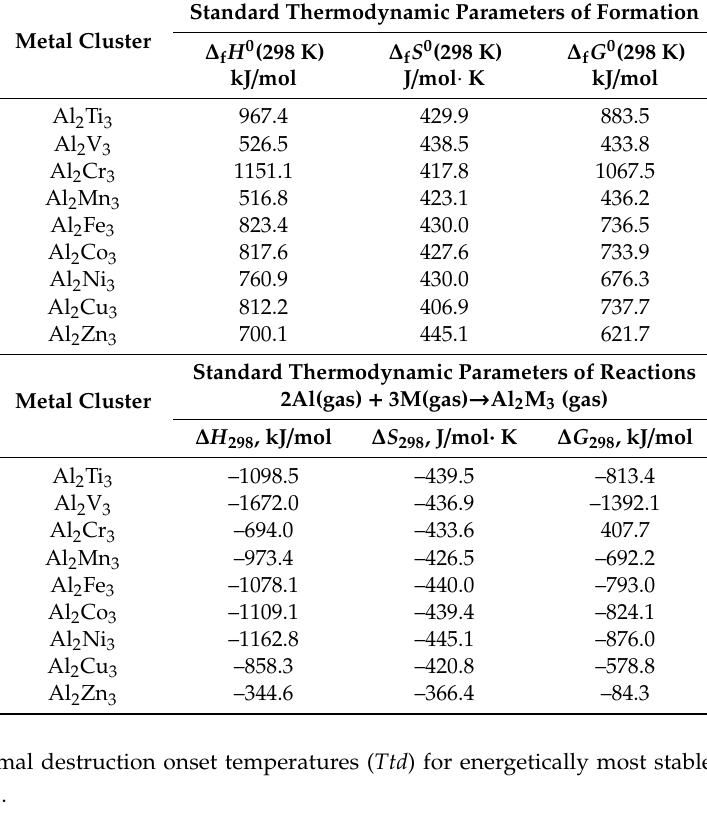
Table 6. Standard thermodynamic parameters of formation for the most energy-stable Al 2 M 3 metal clusters and the reactions of their formation from atoms of the chemical elements constituting them, in the gas phase [92,93].